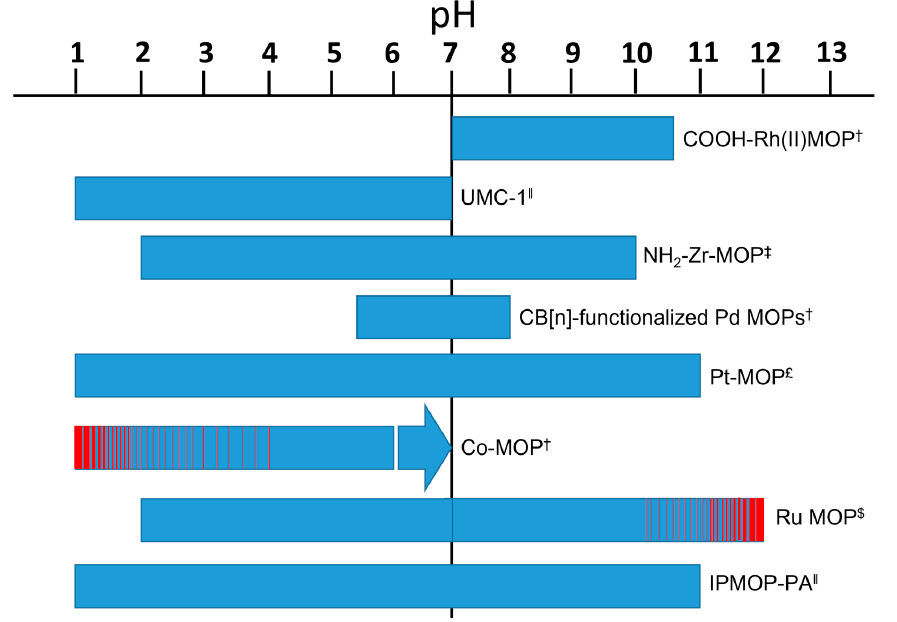
Figure 2. Chemical stabilities of some representative MOPs over the pH range based on literature data. Bar length indicates the pH range that the MOPs remain stable. Arrow represents that the MOP can withstand beyond the pH limit. The red bar indicates the pH ranges that MOPs start to disintegrate. Stabilities are determined by several methods like NMR (†), ESI (‡), powder X-ray diffraction ( (cid:107) ) and fluorescence microscopy ($), apart from those marked with £ representing the methods to determine stabilities are not